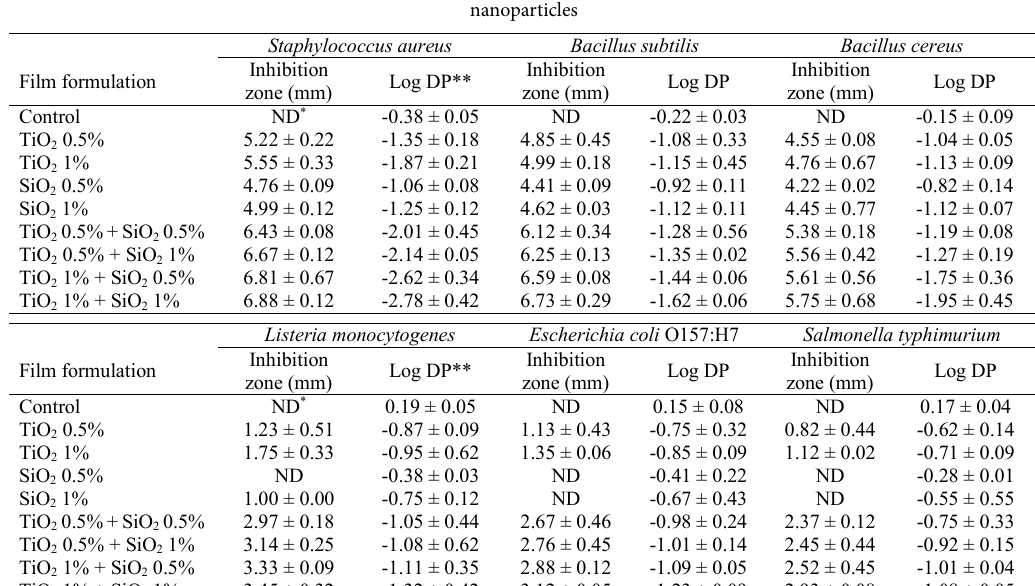
) and Silicon dioxide (SiO ) 2 2